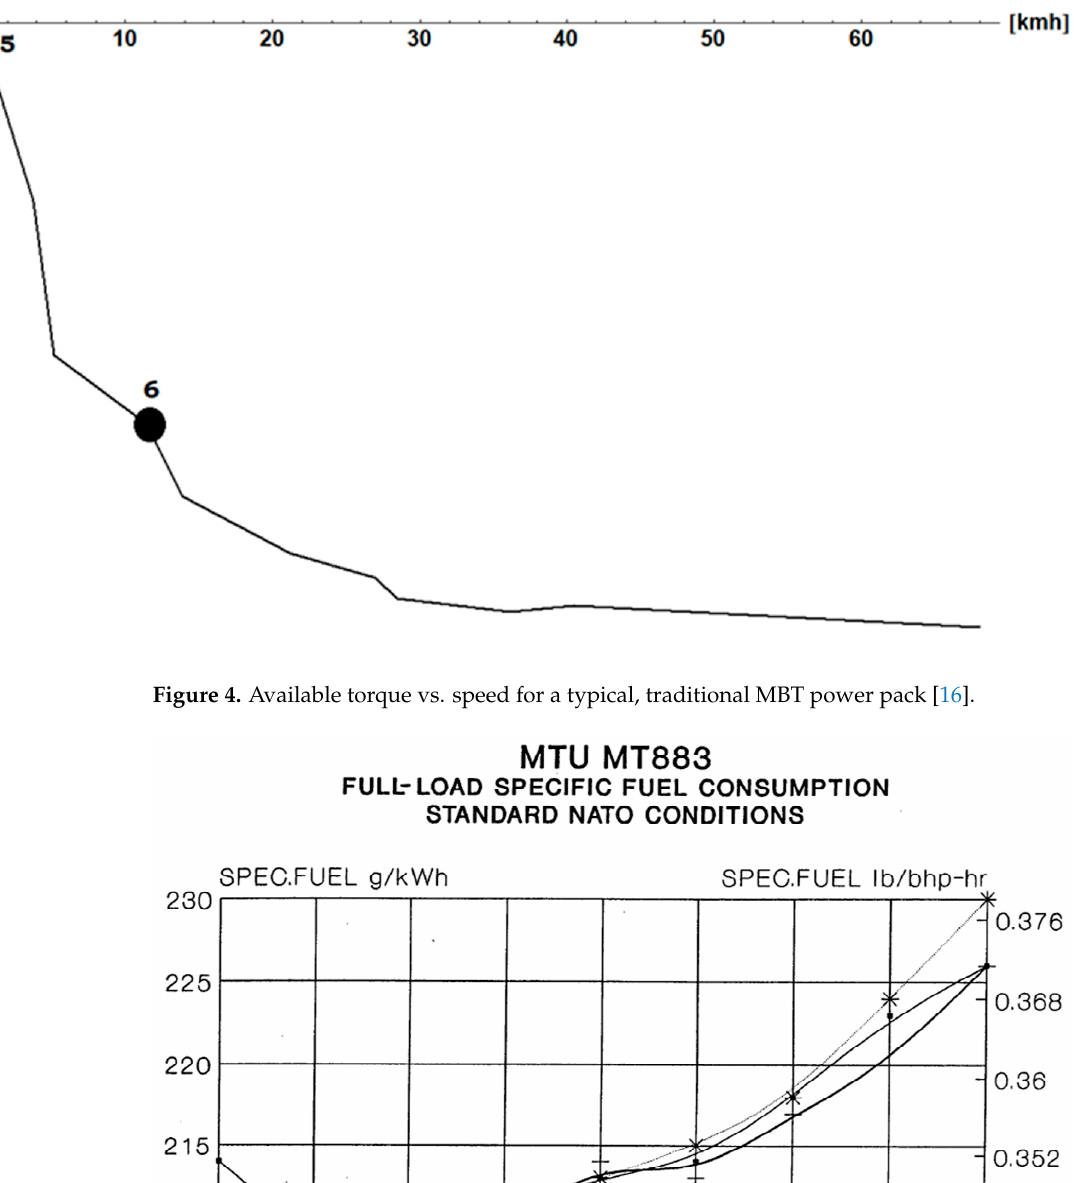
Figure 5. Brake Specific Fuel Consumption of a traditional MBT Engine [17].